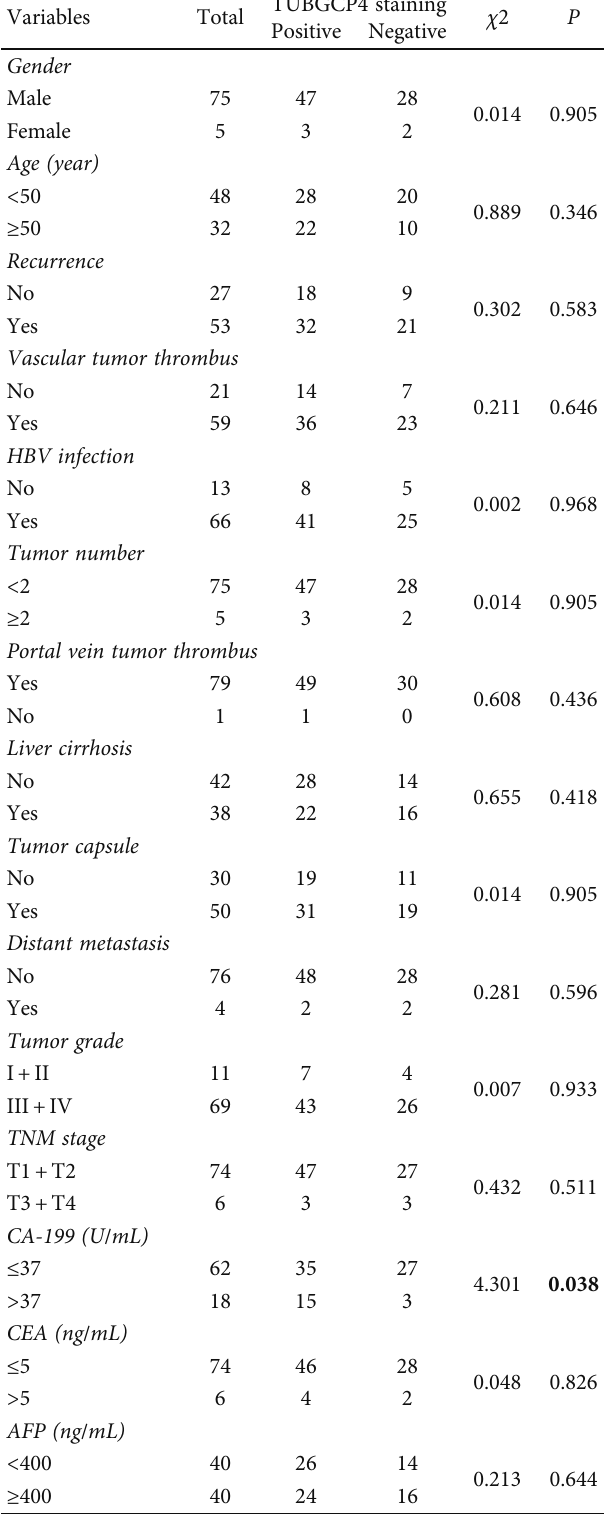
Table 1: Association between the expression of TUBGCP4 and clinicopathological features of HCC